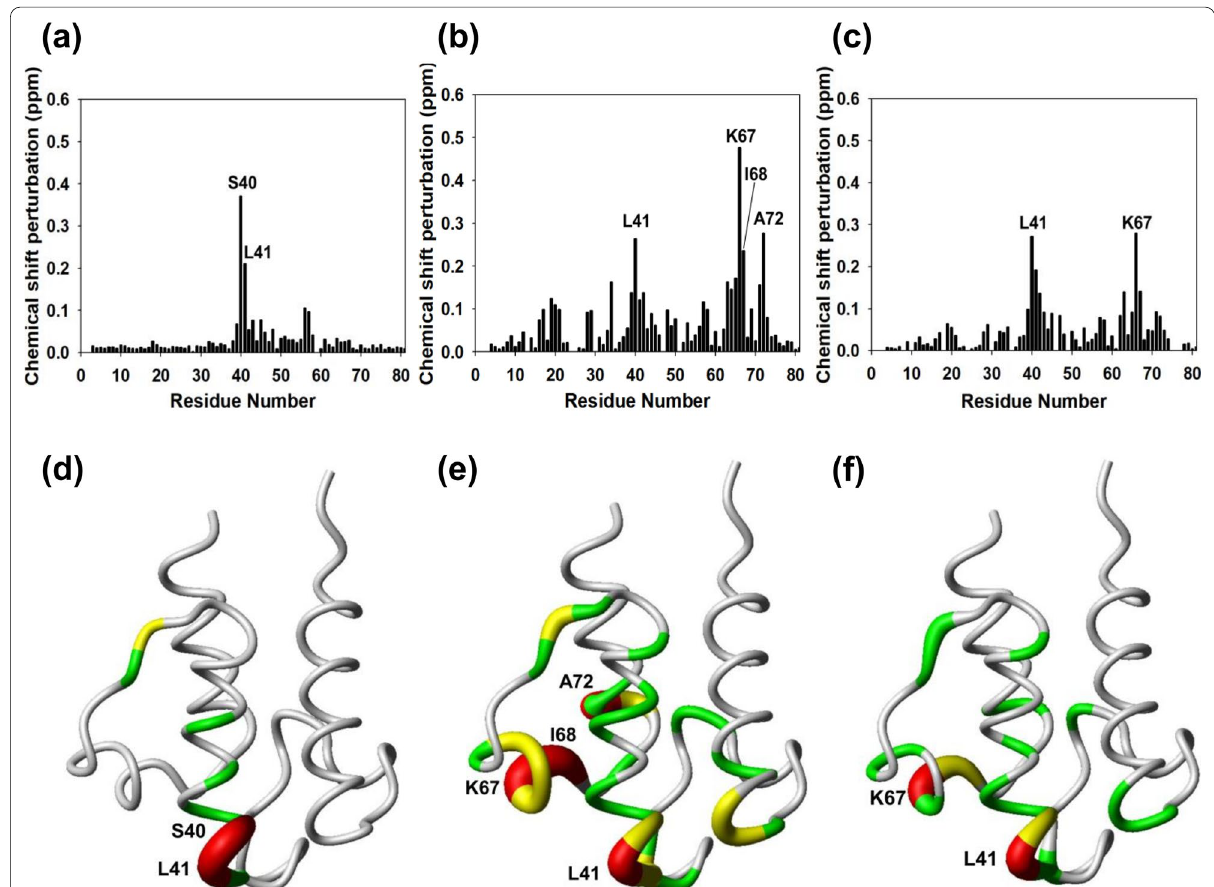
Fig. 5 The chemical shift perturbations of a – c holo, butyryl, and isobutyryl ACP in 1 H– 15 N HSQC spectra from the apo forms of C. acnes . CSPs (Δ δ ) are calculated using the equation Δ δ (0.5(Δ δ ( 1 H) 2 ( α Δ δ ( 15 N) 2 ))) 1/2 ( α 0.2 for most residues, and α 0.14 for glycine). Structural representations = + = = of residues showing large CSPs in d holo-CaACP, e butyryl CaACP, and f isobutyryl CaACP (CSP > 0.2 red, > 0.1 yellow, > 0.05